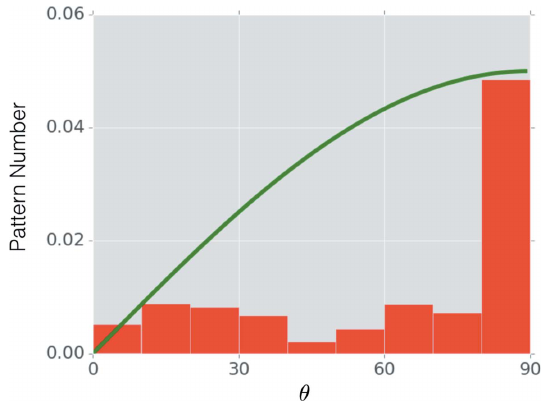
Figure 4 Tilting-angle distribution for 10 878 experimental patterns. The angle (cid:4) is the tilting angle, defined as the angle between the incident beam direction and the direction that is normal to the cubic face, such as the z axis of the particle (see Fig. 1 a ). The green curve is the expected distribution, assuming random orientations. The green curve illustrates that the analytical distribution function p ( (cid:4) ) is proportional to sin( (cid:4) ).